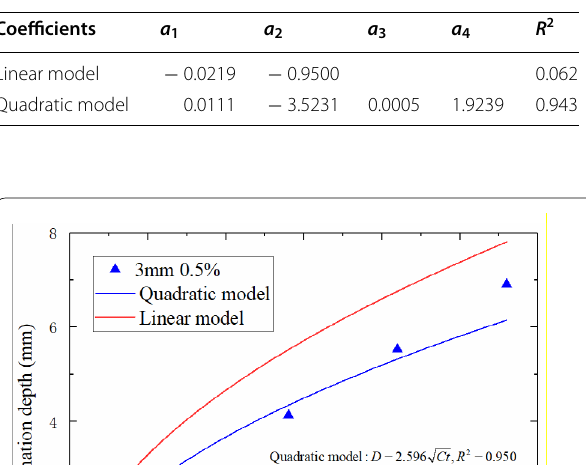
Table 6 Multiple regression coefficients.